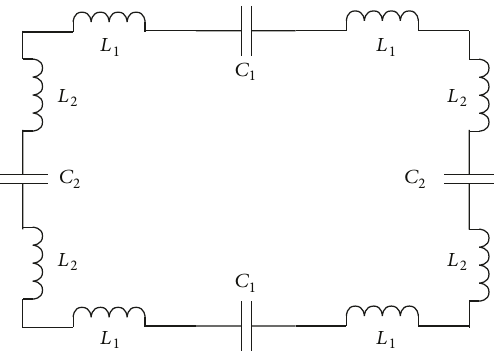
Figure 2: Equivalent circuit of the structure in Figure